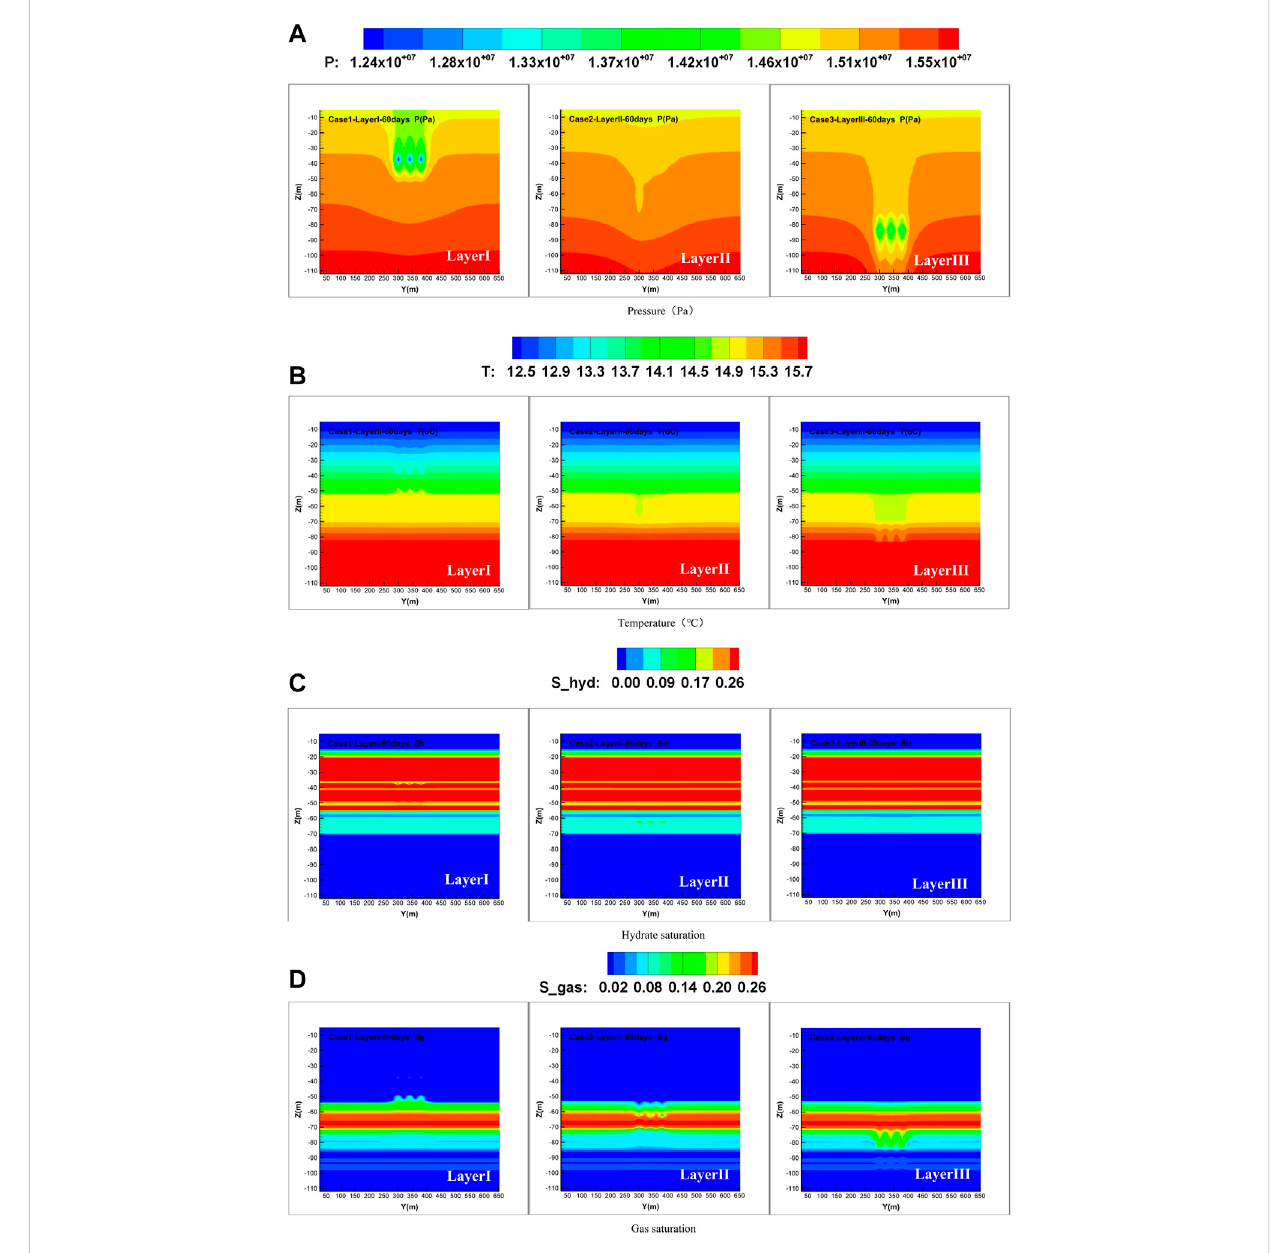
FIGURE 6 Spatial distribution of pressure (A) , temperature (B) , hydrate saturation (C) , and gas saturation (D) after 60 days of depressurization production with different